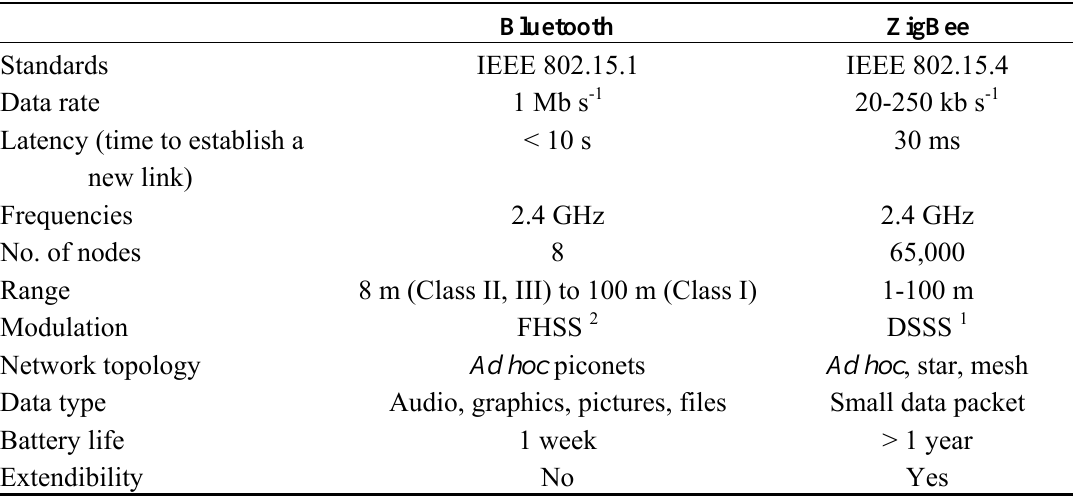
Table 1. Comparison between Bluetooth and